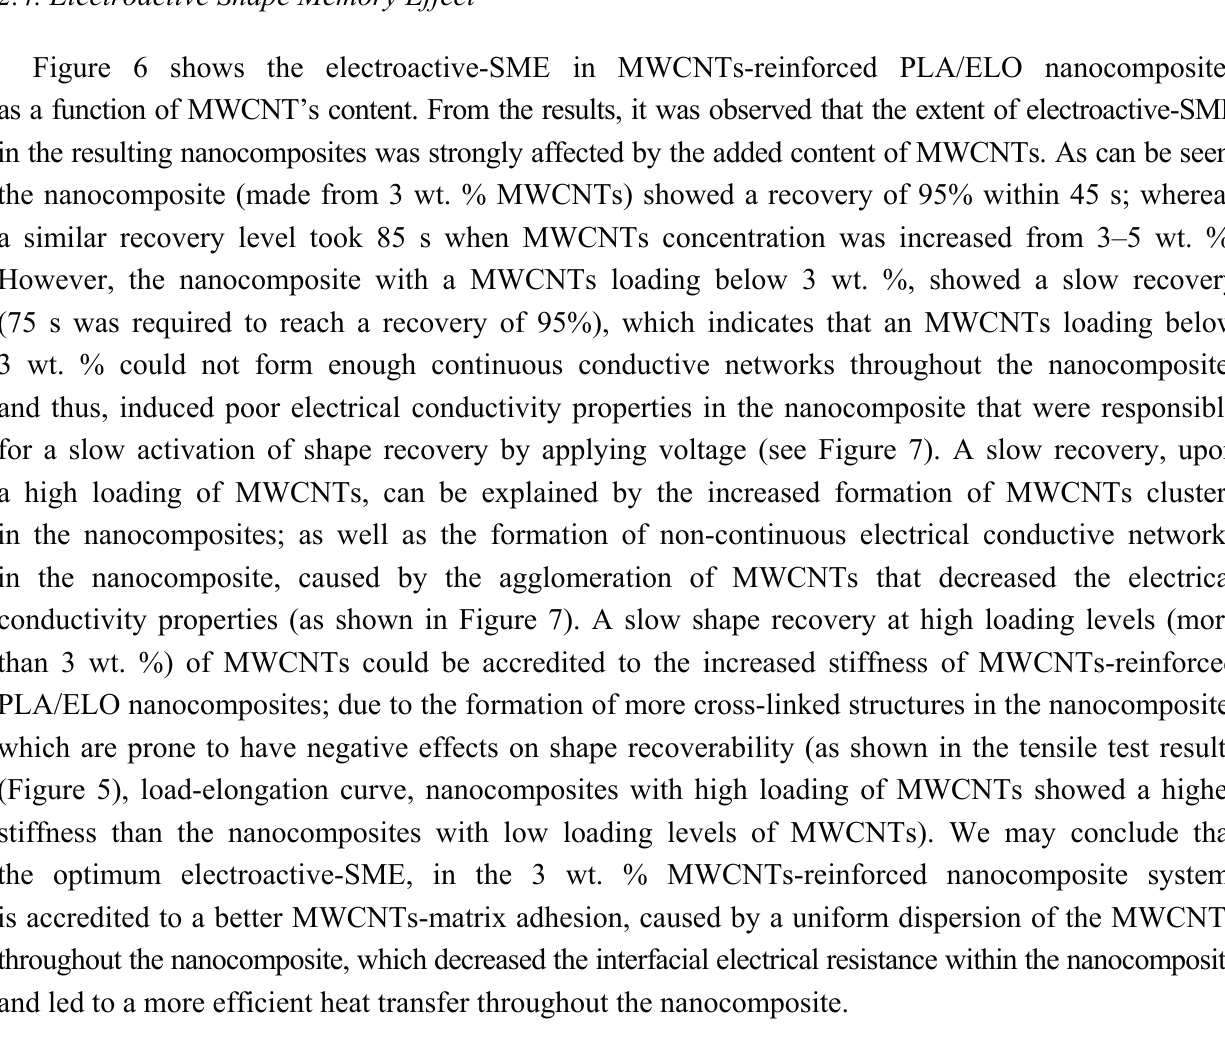
Figure 6. Shape recovery at DC voltage 40 V for the 2, 3 and 5 wt. % MWCNTs reinforced ELO plasticized PLA